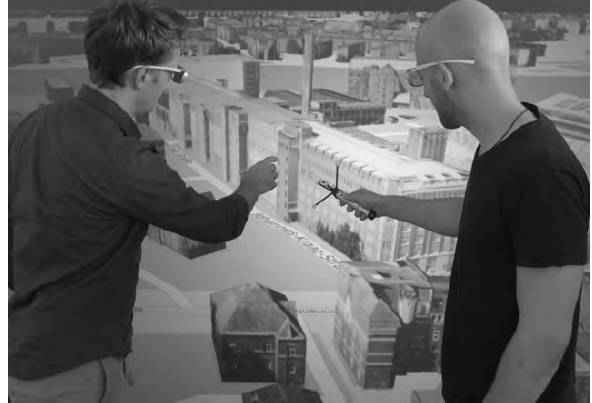
Figure 1. Urban planning use case (© Berlin Partner für Wirtschaft und Technologie GmbH, VENTUS).